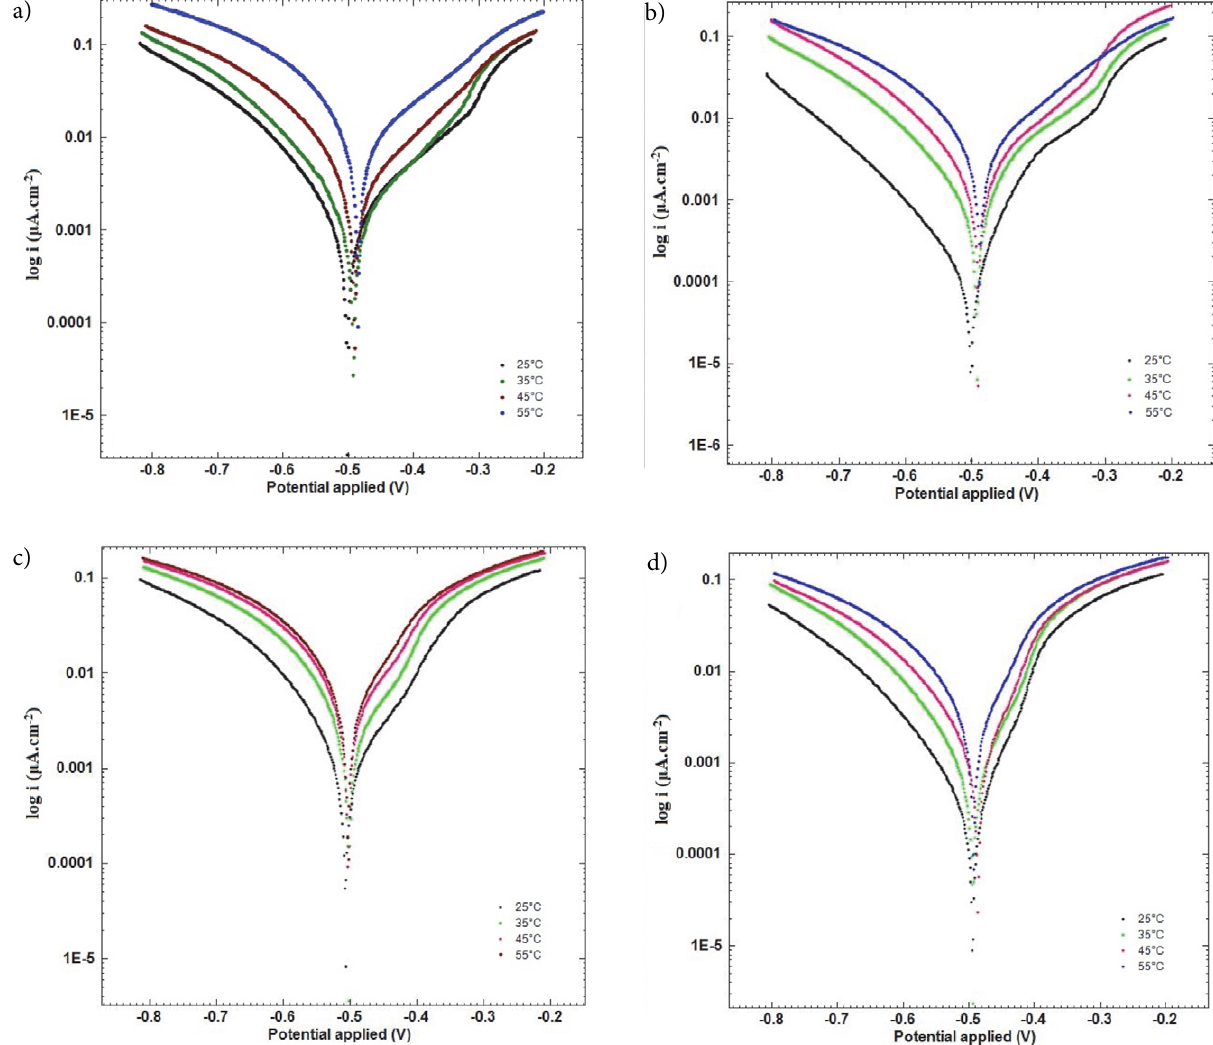
Figure 5. Effect of temperature on the polarization curves in 1 M hydrochloric acid solution a) without inhibitor b) with 300 ppm of inhibitor and 0.5 M sulfuric acid solution c) without inhibitor d) with 300 ppm of inhibitor. (The experiments were repeated at least two